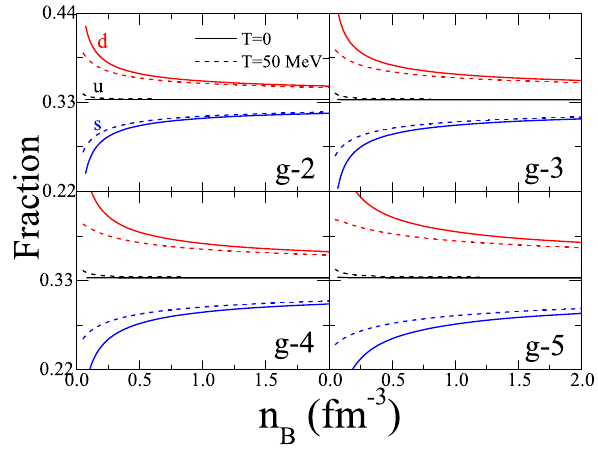
Fig. 4 Entropy per baryon for SQM as a function of the baryon density with g-2, g-3, g-4, and g-5 in different temperature